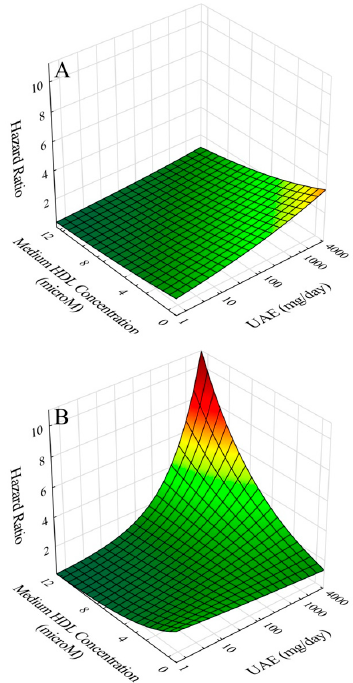
Figure 3. Hazard ratio for cardiovascular disease risk as a function of urinary albumin excretion (UAE) and medium-size HDL particle concentration: ( A ) without inclusion of interaction of UAE and HDL particle concentration; and ( B ) with inclusion of interaction of UAE and HDL particle concentration.